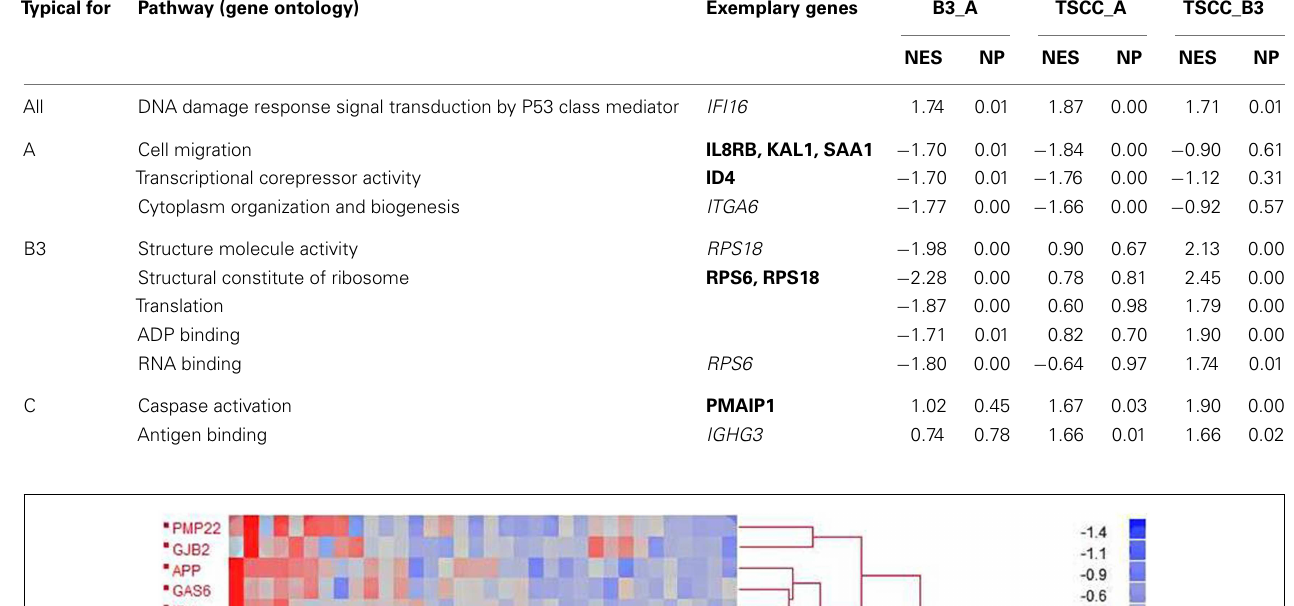
Table 3 | Significantly enriched functional pathways in typeA and B3 thymomas andTSCC using normalized enrichment scores (NES) of > 1.6 and p < 0.05 between at least two comparisons; NP, normalized p -values (24).The “exemplary genes” are the genes with the strongest ( > 1.3-fold) significant ( p < 0.05) differential expression in the indicated Gene Ontology pathway. Genes given in bold are discussed in the text.